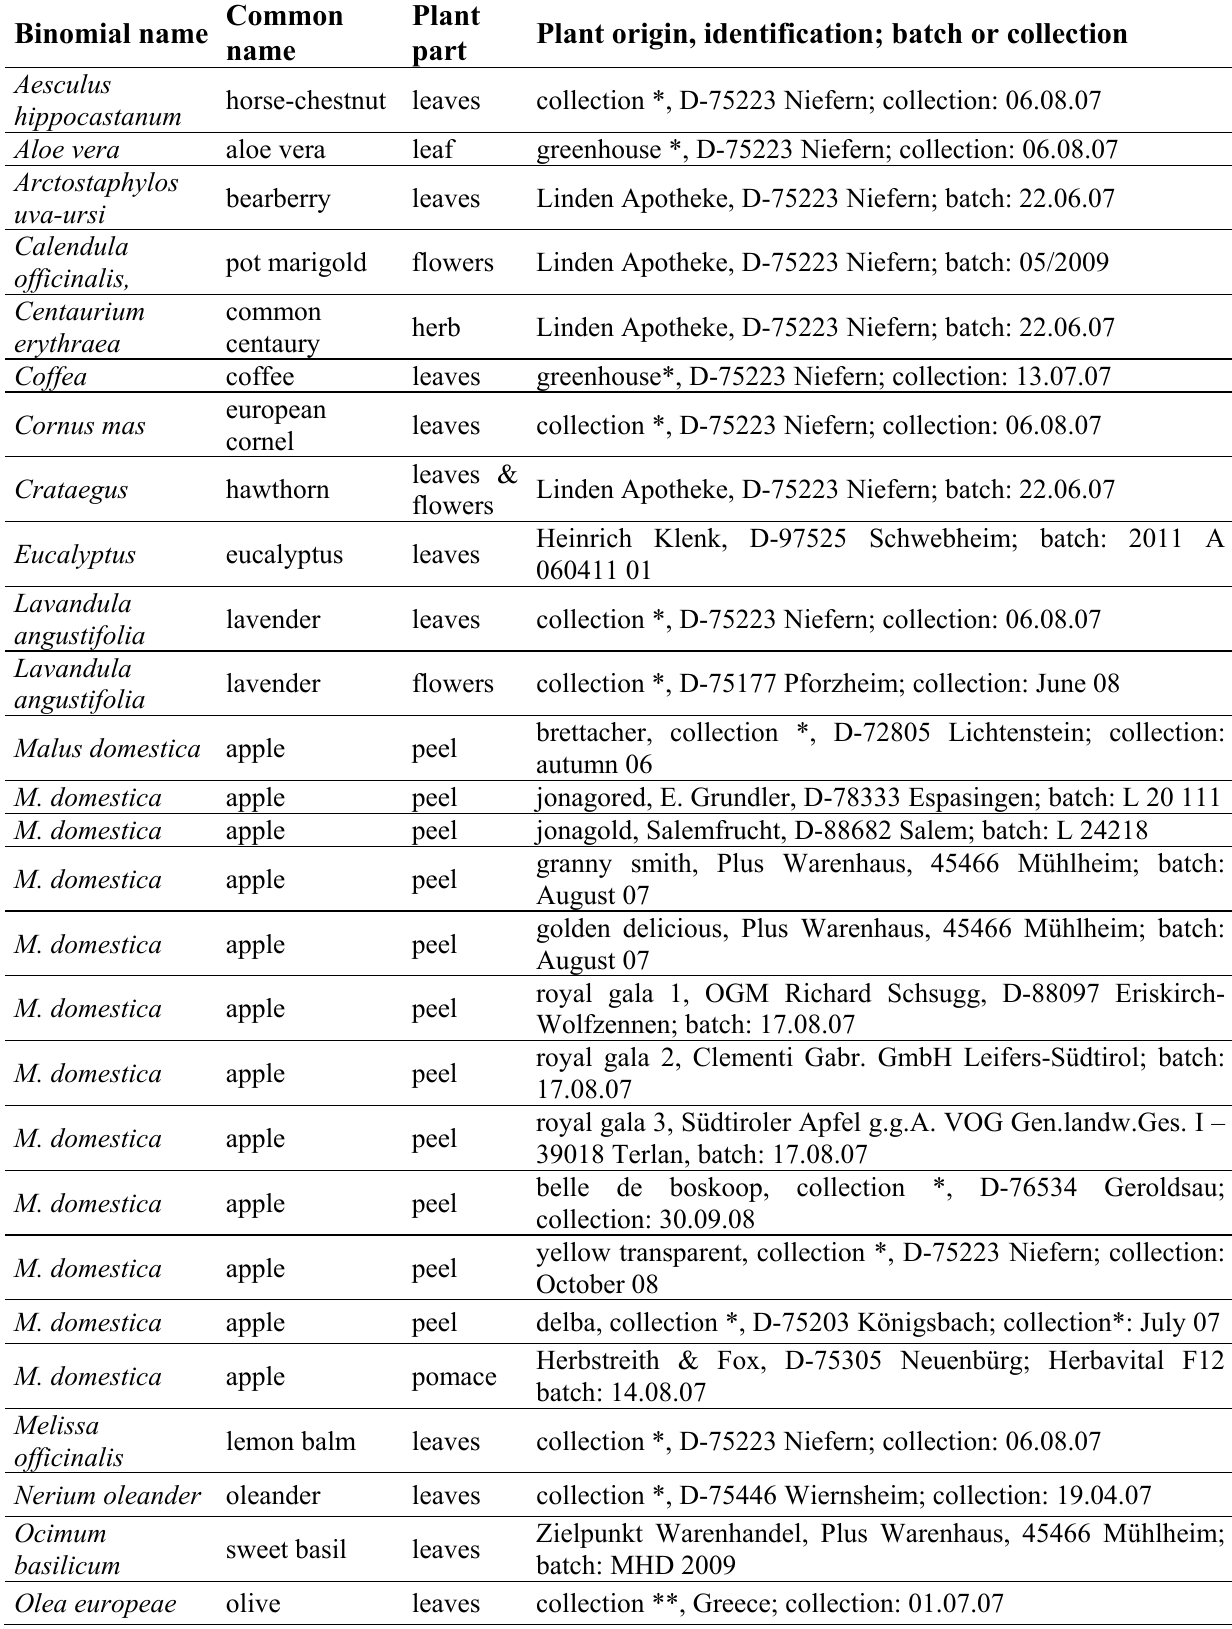
Table 4. Plant material and plant parts used for analysis and extraction of